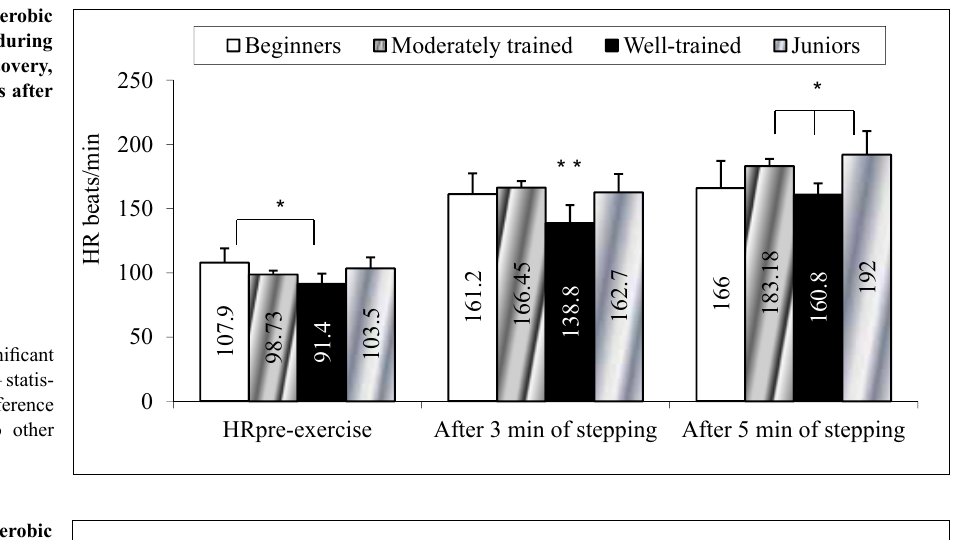
Figure 1. HR values of aerobic gymnastics athletes during the first minute of recovery, 3